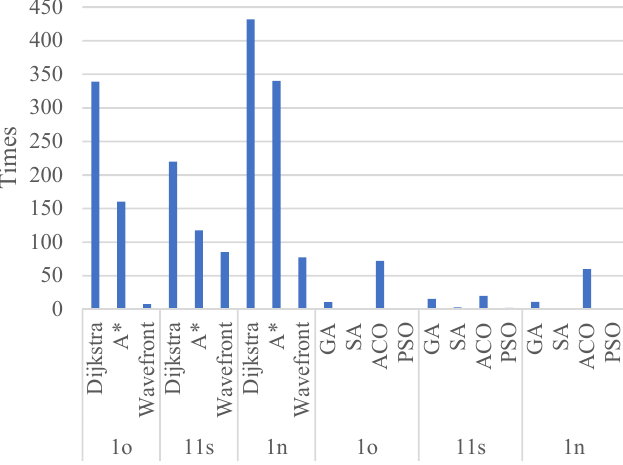
Figure 14. The process time increasing rate between 40 probs and 10 probs.